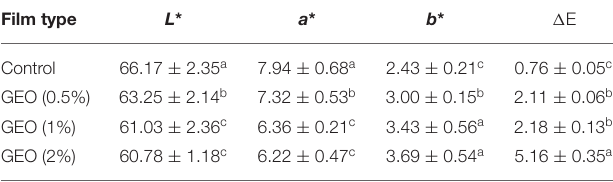
TABLE 5 | Color parameters ( L *, a *, b *) of cassava starch-based films. Film